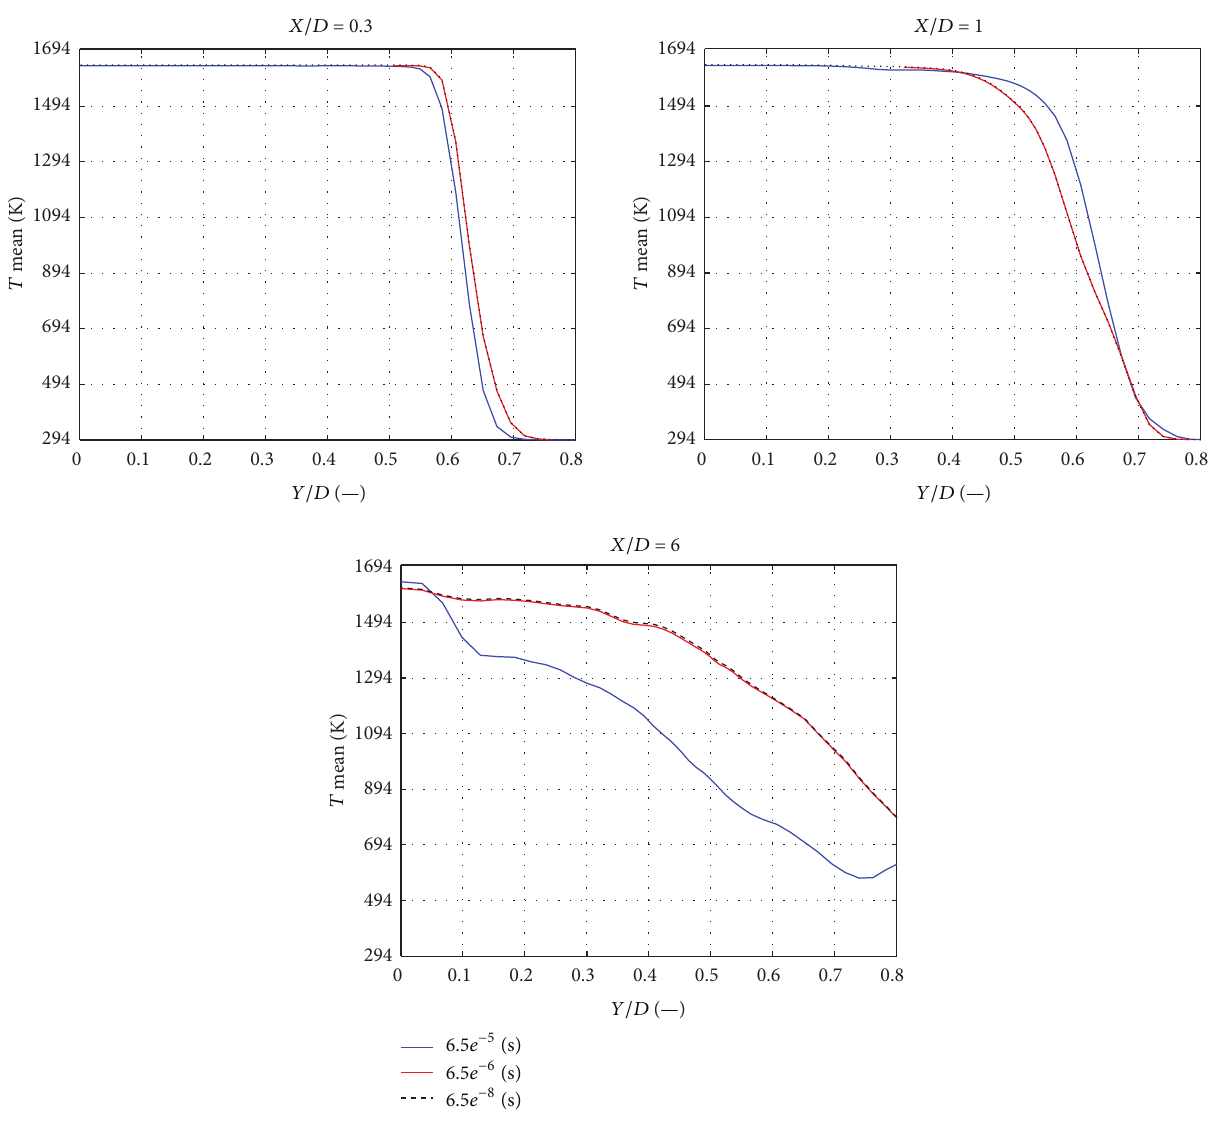
Figure 4: Mean temperature profiles resulting from time step size sensitivity analysis.